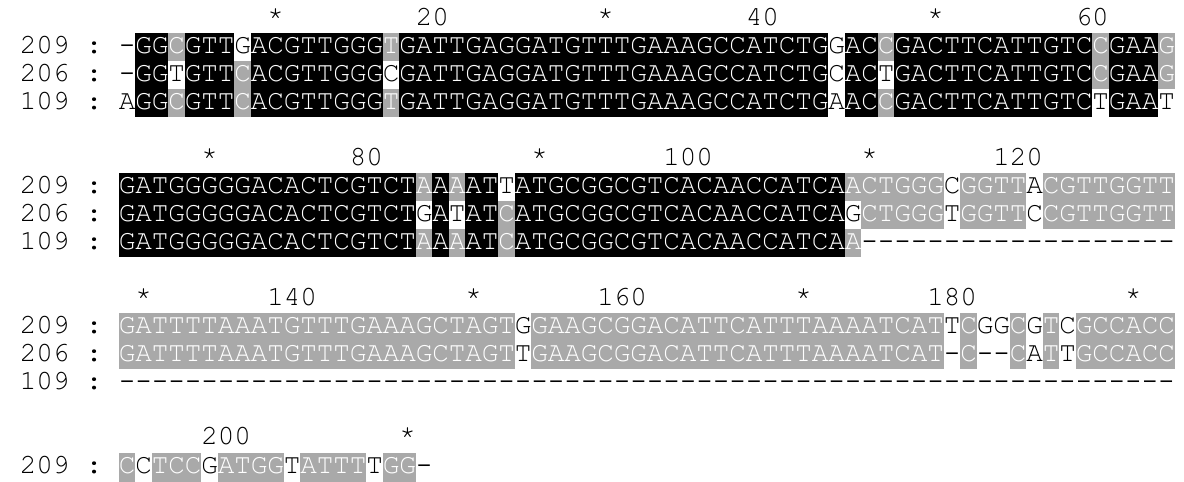
Figure 5. The alignment of the delCS ‐ 237 monomers from the 52978632nd–52979130th bp region of the WRXK01000002 contig.